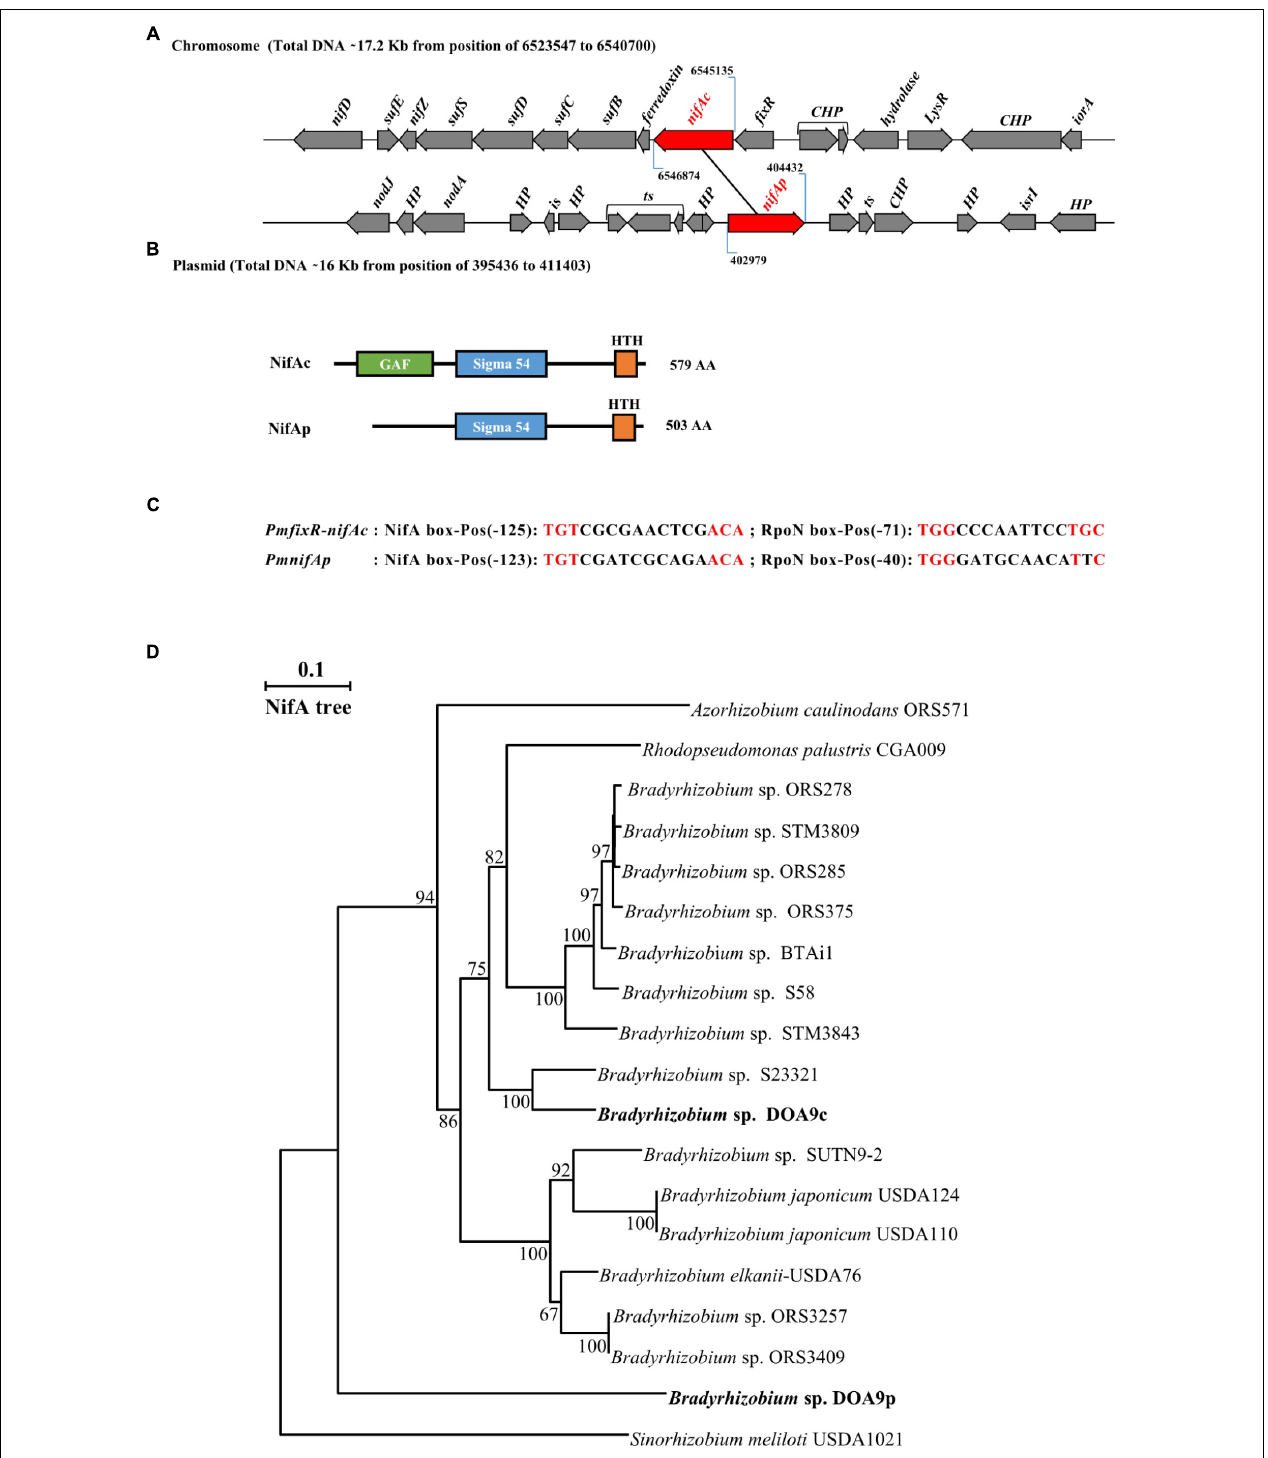
FIGURE 1 | Bradyrhizobium sp. strain DOA9 strain displays two distinct nifA genes. (A) Genetic organization of the two nifA genes (in red) located on both the chromosome and plasmid of the DOA9 strain. nifAc, nifA located on the chromosome; nifAp, nifA located on the plasmid; CHP: Conserved Hypothetical protein, HP: Hypothetical protein, is : intregrase and ts : transposase. (B) Predicted domain structure of both NifA proteins. (C) Putative NifA and RpoN boxes identified in promoter region of fixR-nifAc operon and nifAp . Pos: position of 5 (cid:48) end nucleotide of motif relative to annotated start codon. (D) NifA phylogenetic tree showing relationship between NifA of bradyrhizobia. Sequences were aligned by CLUSTALX, and the tree was generated using the neighbor-joining method (Saitou and Nei, 1987) and displayed using NJPLOT (Perrière and Gouy, 1996). Bootstrap values, expressed as percentages of 1000 replications, are shown at branching points.